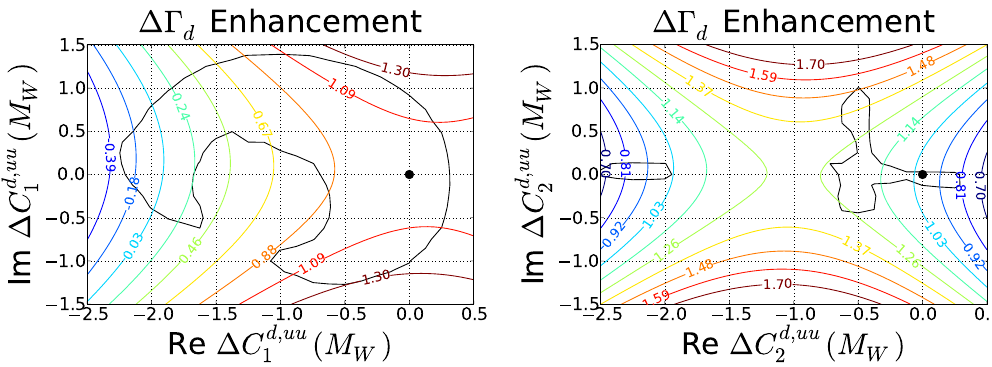
Figure 18 . Global (cid:31) 2 -(cid:12)t including observables constraining the inclusive transition b ! u (cid:22) ud . The 90% C.L. allowed regions correspond to the areas contained within the black contours. The colored curves indicate the possible enhancements on (cid:1)(cid:0) d with respect to the SM value. The black dot corresponds to the SM